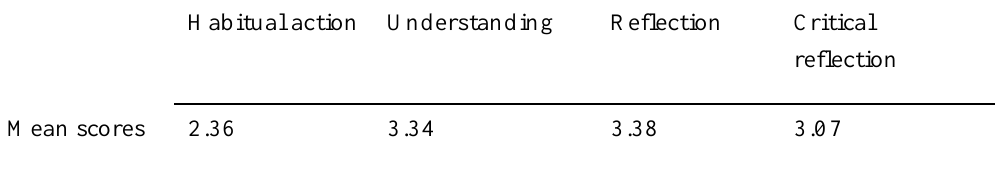
Presence of Four Levels of Thinking in AIOU